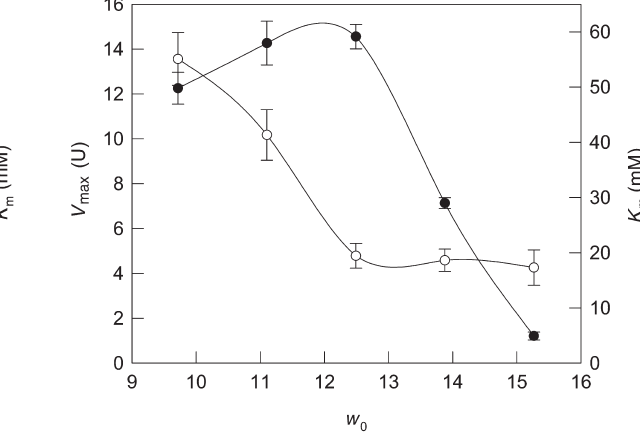
Figure 5. Effect of water content on the kinetic parameters of p NPPase from H. salinarum ( V max ) in reverse micelles (0.2 M CTAB and 1 M 1-butanol in cyclohexane): V max ( (cid:4) ) and K m ( (cid:5) ). The en- zyme concentration in the water pool ([E] wp ) was held constant at 1.6 µg ml –1 . The reaction was initiated by mixing reverse micelles containing enzyme with reverse micelles containing substrate. The buffer in the water pool was 100 mM Tris-HCl, pH 8.5,